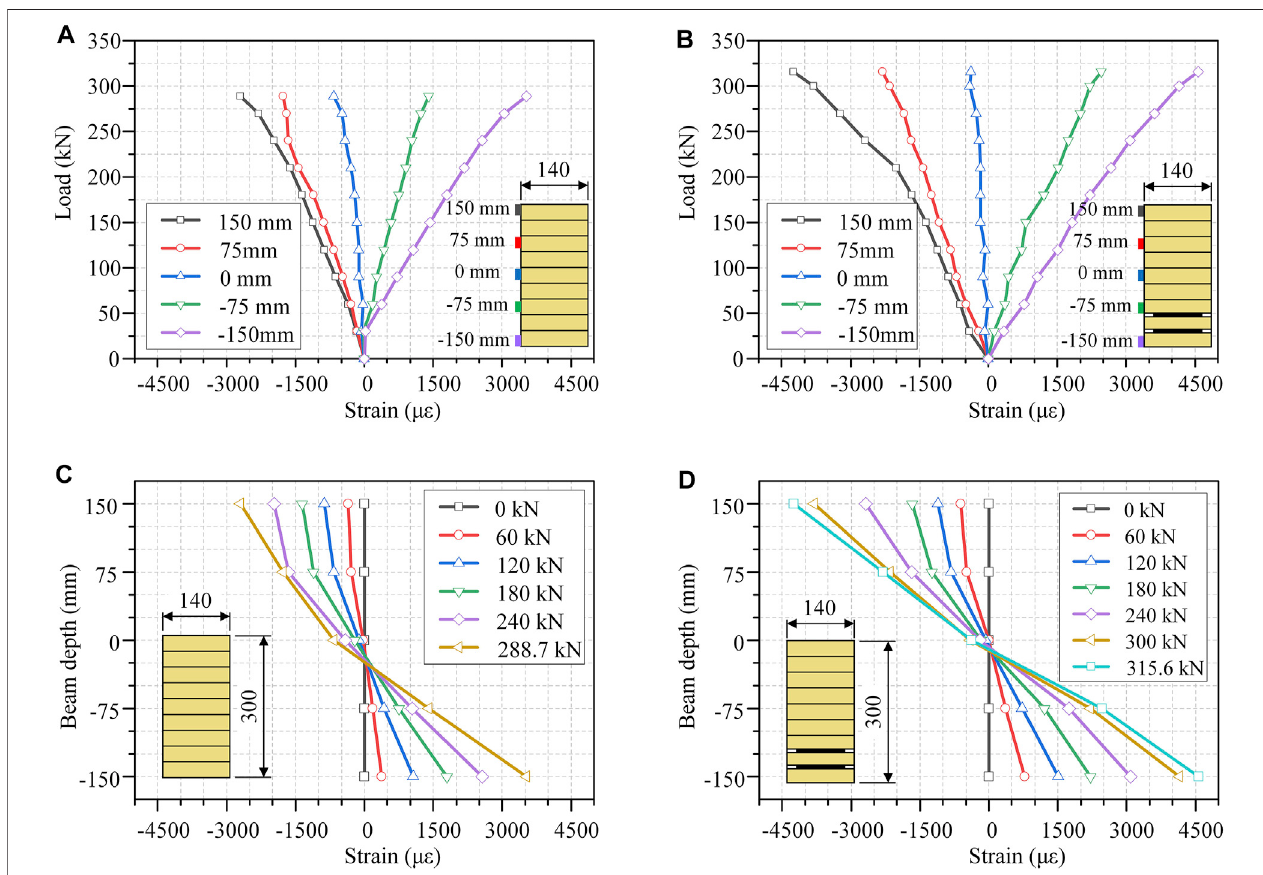
FIGURE 6 | Strain distribution: load – strain curves of (A) group W and (B) group WH+H; and strain pro fi le of (C) group W and (D) group WH+H.